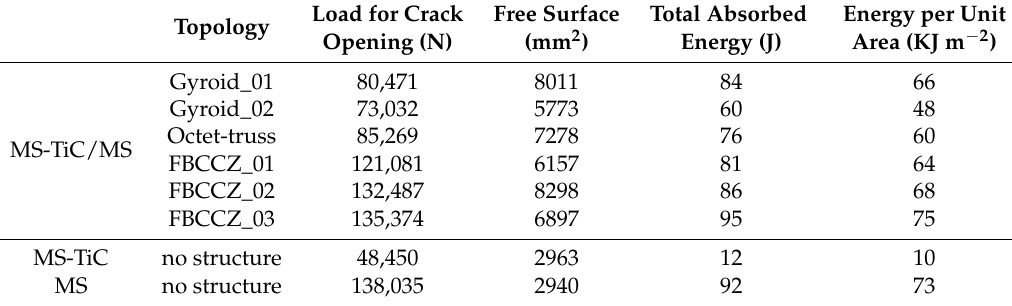
Table 3. Mechanical response of each specimen configuration at the maximum